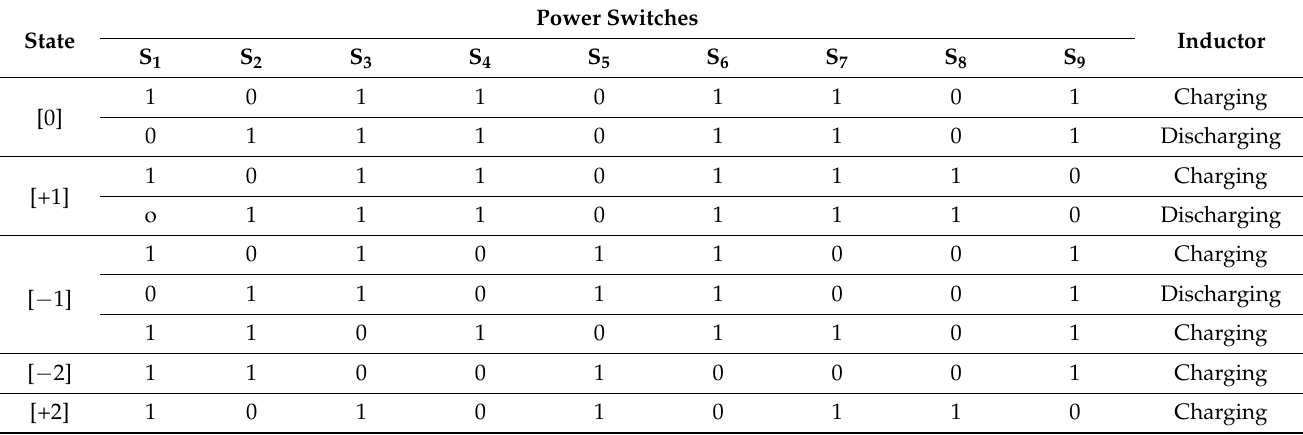
Table 1. Switching states of the proposed inverter.